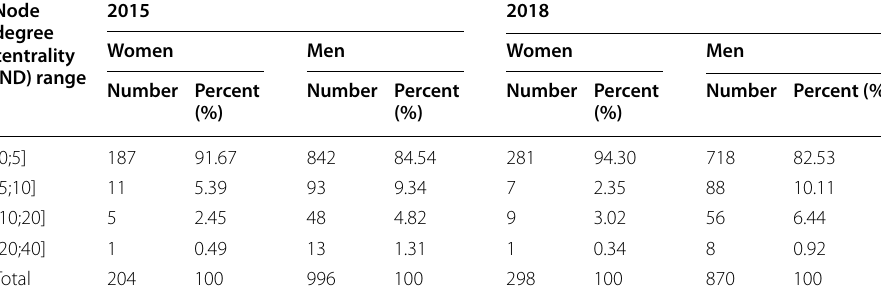
Table 2 Node degree centrality ranges by gender (2015 and 2018) Node degree centrality (ND)